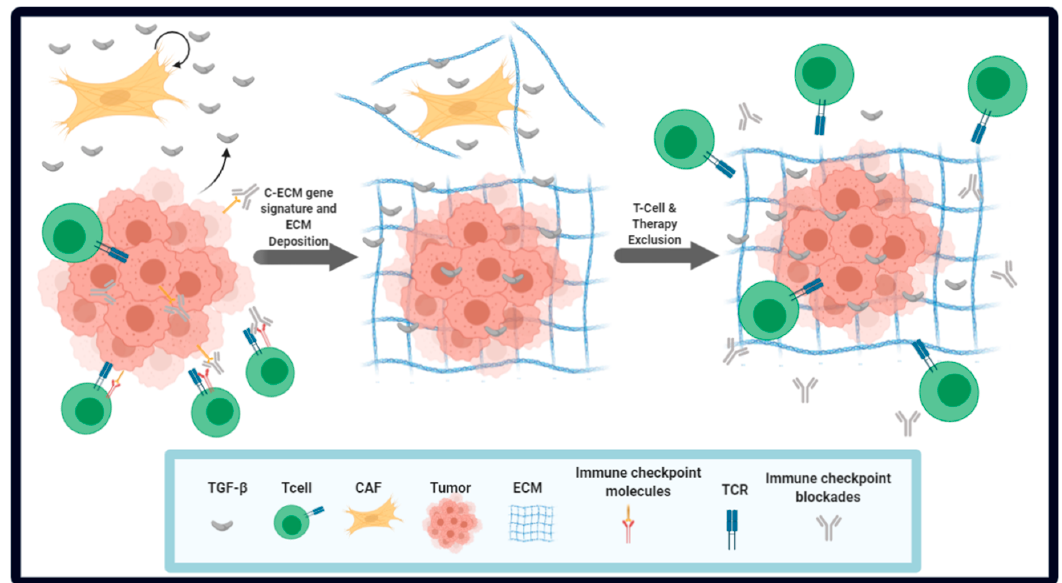
Figure 1. Tumor microenvironment-associated cells and extracellular components as regulators of tumor formation, survival and progression: The schematic depicts how the interplay between the tumor cells and the surrounding stroma cells including cytotoxic T-cells and cancer-associated fibroblasts (CAFs) helps in promoting tumor cell proliferation and survival mainly through evasion of attack by the immune system. Recent data support the idea that CAFs play a key role in immune evasion. In particular, tumor and mainly CAFs promote the synthesis, secretion, and activation of TGF- β in the tumor microenvironment. TGF- β , in turn, acts on CAFs, leading to extracellular matrix (ECM) remodeling to limit access of cytotoxic T-cells and immune checkpoint blockade to the tumor.